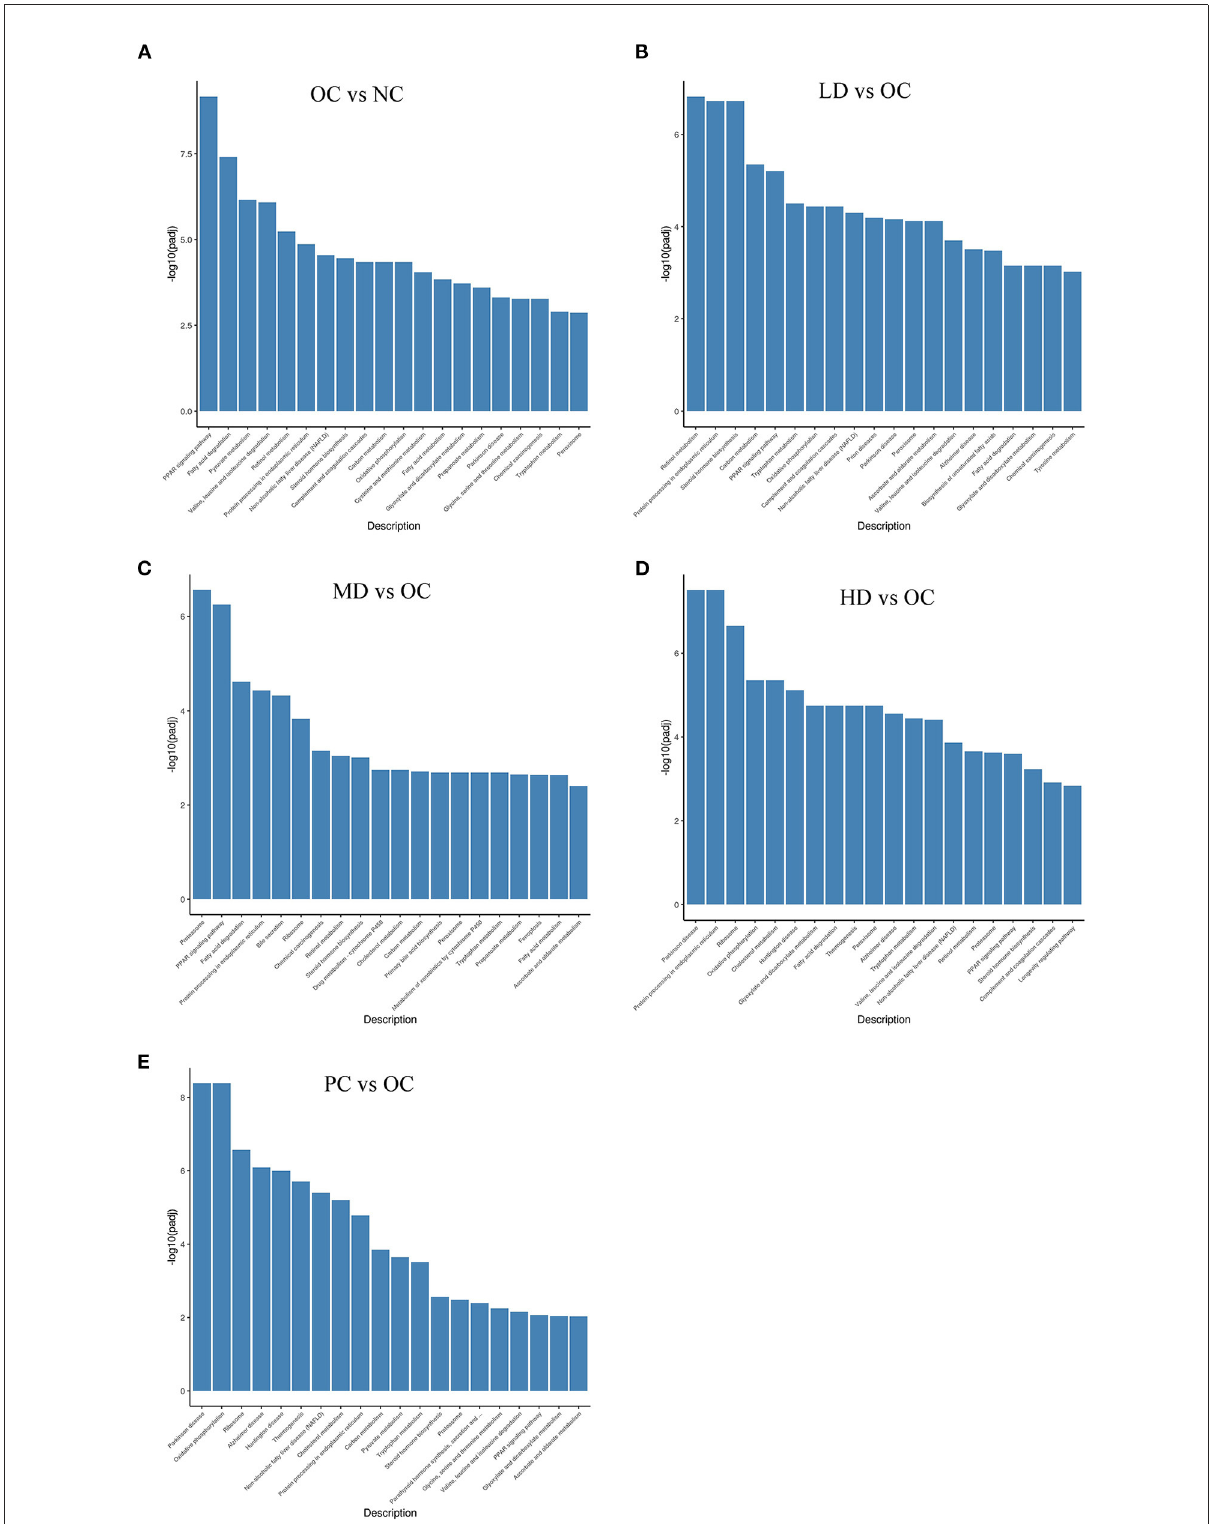
FIGURE6 KEGG enrichment of differential genes (A) OC vs. NC (B) LD vs. OC (C) MD vs. OC (D) HD vs. OC (E) PC vs. OC. The abscissa is KEGG pathway, and the ordinate is the significant level of pathway